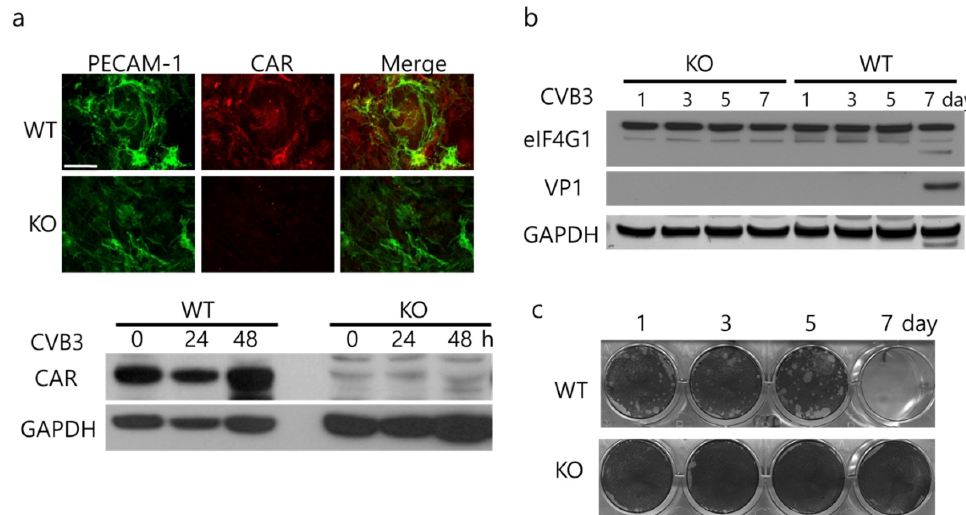
Figure 2. CVB3 replication is delayed in endothelial cells. ( a ). WT and CAR-eKO (KO) endothelial cells were immunostained with antibodies against platelet endothelial cell adhesion molecule-1 (PECAM-1, green) and CAR (red) and analyzed by fluorescence microscopy (scale bar, 40 µm). Cell extracts were subjected to Western blot analysis using indicated antibodies. ( b ). WT and KO endothelial cells were treated with 1 m.o.i. CVB3 and then the cells were lysed at day 1, 3, 5, 7. Endothelial cell extract proteins were subjected to Western blot analysis using indicated antibodies. ( c ). Supernatants of CVB3-infected WT and KO cells were subjected to plaque forming unit (PFU) assay to measure release of virus into the supernatant.